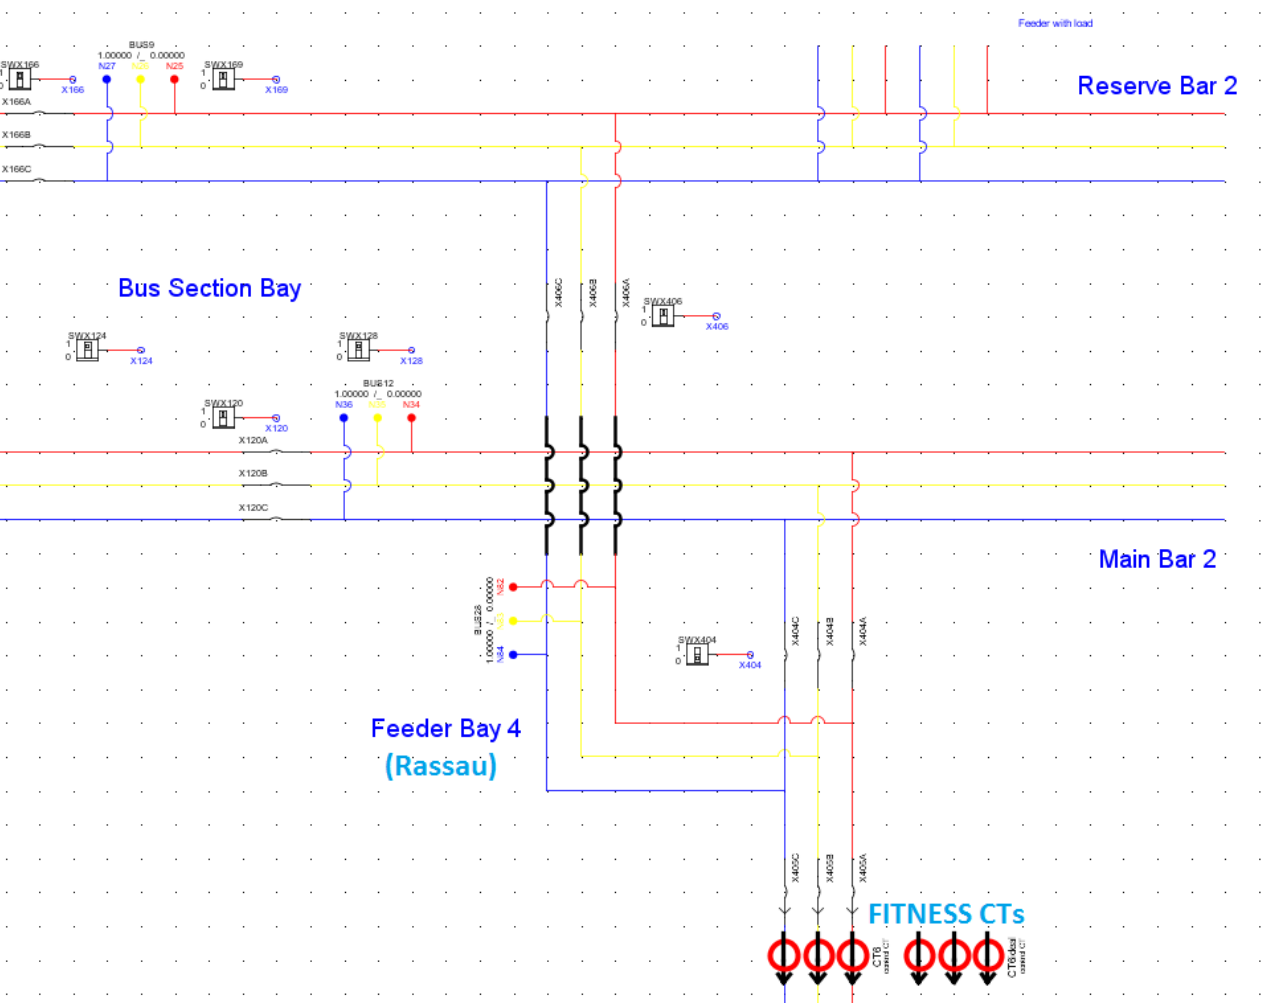
Figure 3. Point of connection for future intelligent transmission network substation CTs within RSCAD network model.